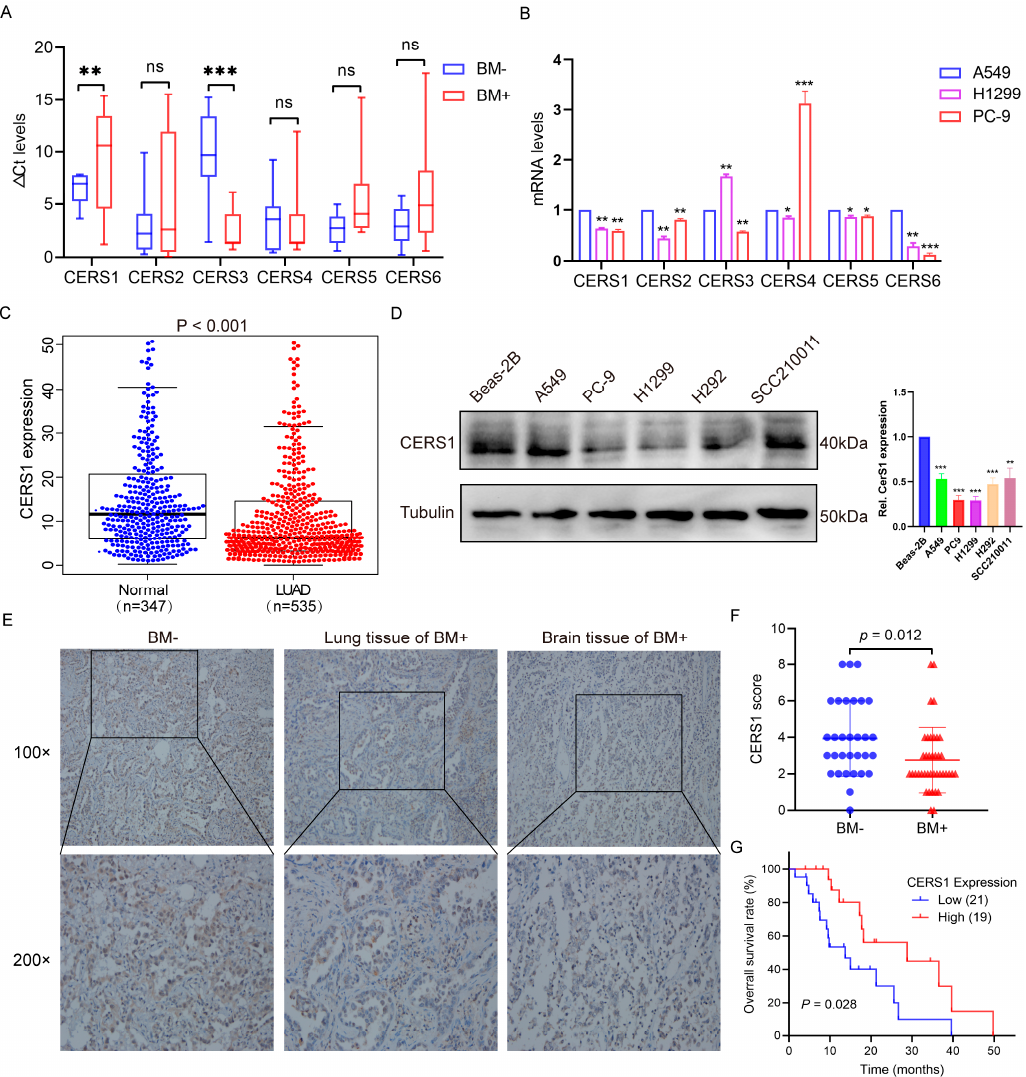
Figure 1. CERS1 exhibits low expression in patients with NSCLC BM. ( A ) mRNA levels of CERS1-6 in fresh NSCLC and BM tissues. ( B ) mRNA expression of CERS1-6 in NSCLC cell lines with different BM tendencies. ( C ) CERS1 expression in lung adenocarcinoma and normal tissues based on TCGA and GTEx database analyses. ( D ) CERS1 expression in NSCLC cell lines was tested via western blotting. ( E ) Representative immunohistochemical staining images of CERS1 in lung tissues